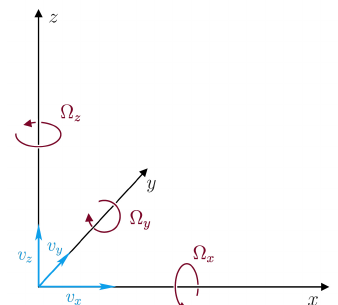
Figure 1. Sign conventions for translational and rotational components used in this study. The x -axis points to the